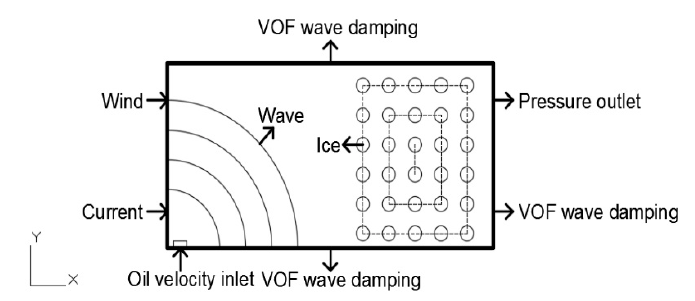
Figure 3. Computational domain.